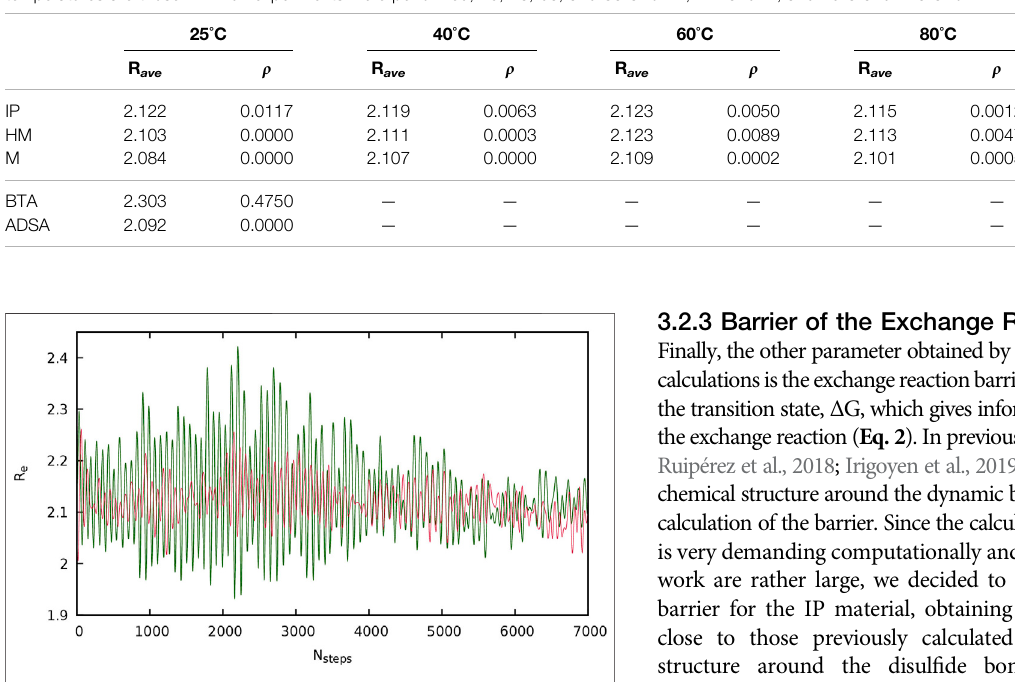
FIGURE 6 | Variation of the S-S bond length (R e ), in Å, in the QMD simulationsforeachchaininthetwo-chainmodelofIPmaterial(redandgreen lines). N steps states for number of steps in the